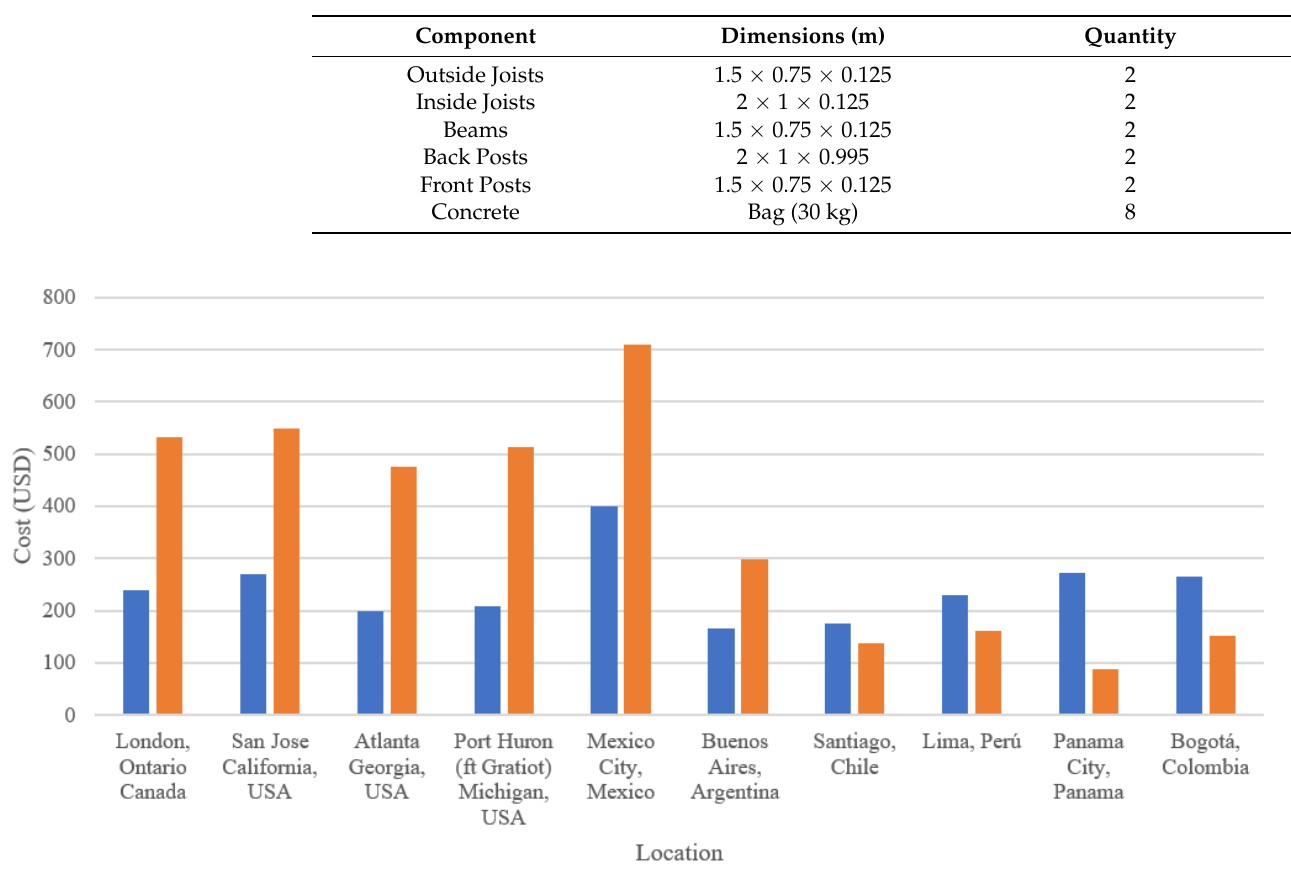
Table 2. BOM for the fixed-tilt aluminum-based PV racking system. Component